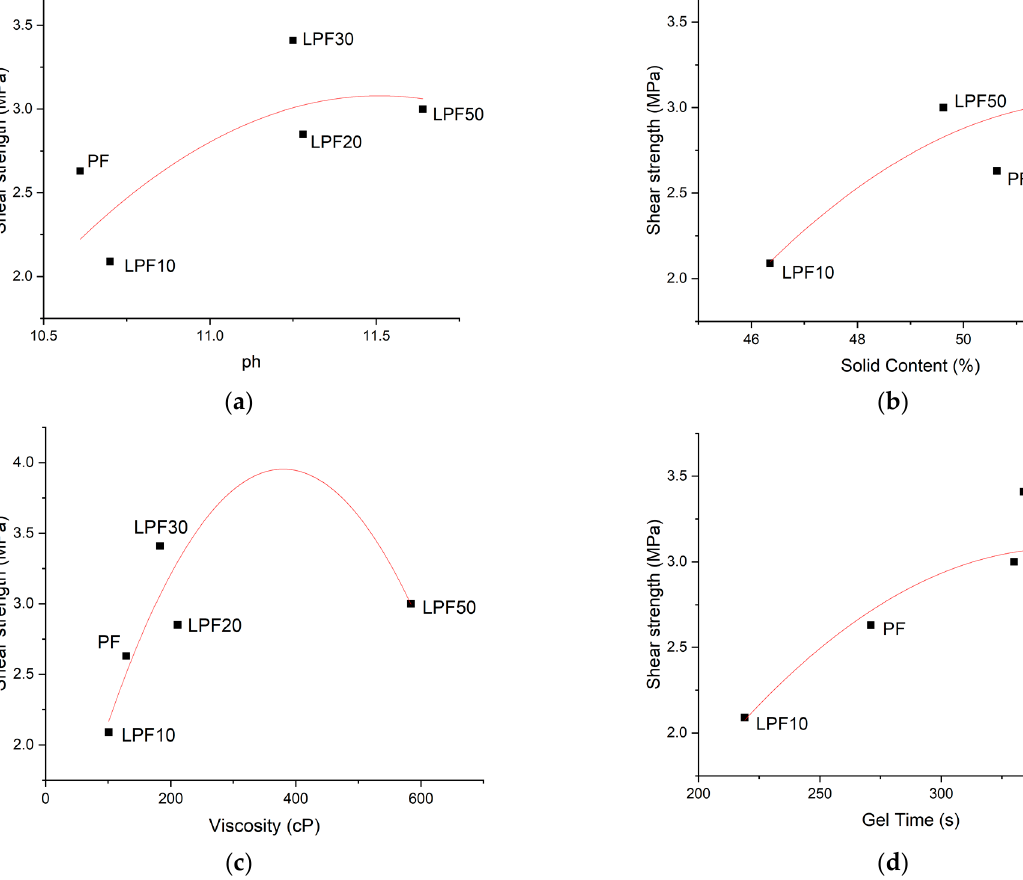
Figure 3. Development of tensile shear strength of different resins as a function of: ( a ) pH, ( b ) solid content, ( c ) viscosity, and ( d ) gel time. content, ( c ) viscosity, and ( d ) gel